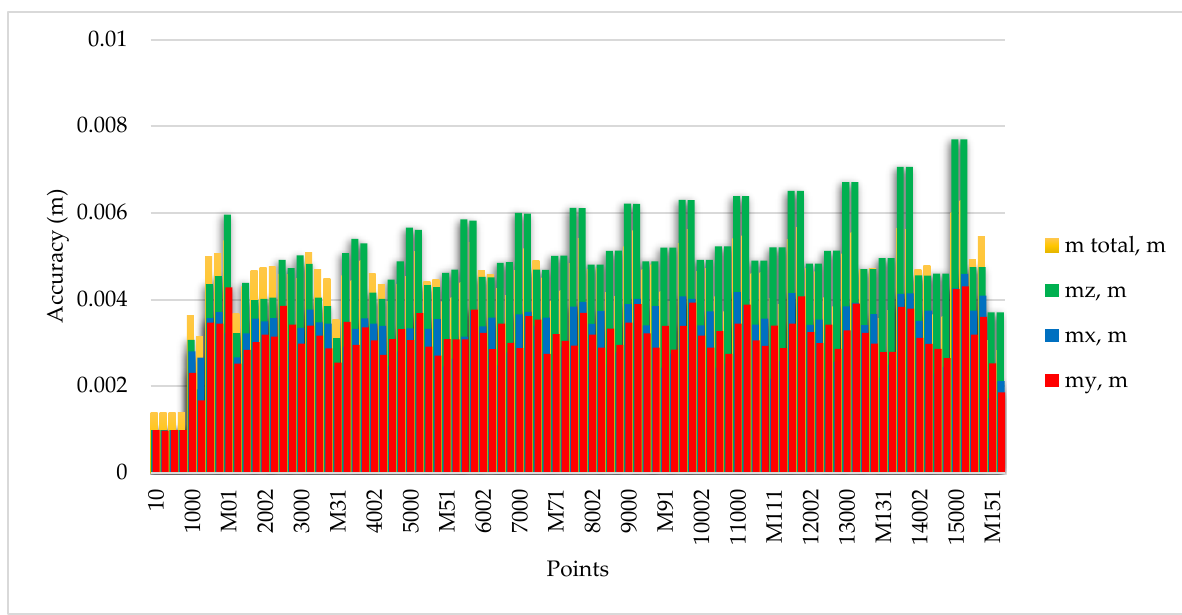
Figure 26. Accuracy of absolute coordinate determination with additional GNSS observations.